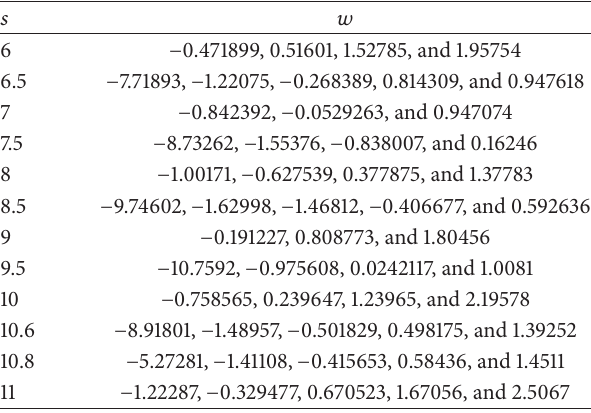
Table 2: Approximate solutions of 𝐸 𝑞 (𝑠, 𝑤) = 0, 𝑤 ∈ R